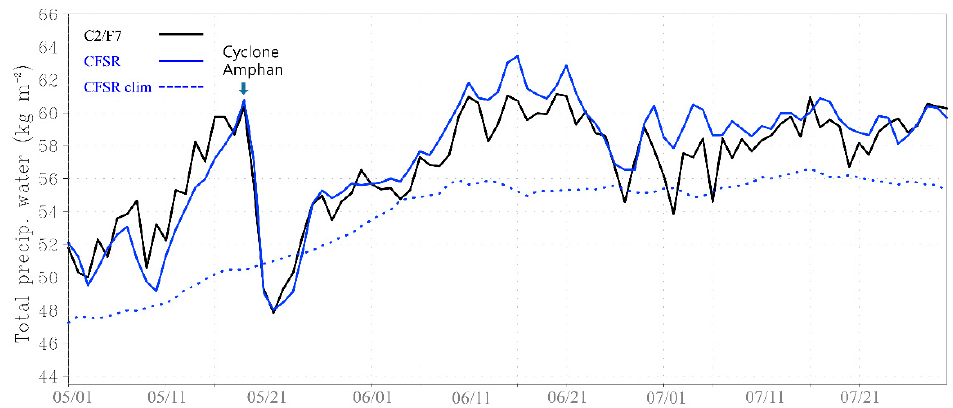
Figure 7. The daily total precipitable water in the Bay of Bengal during 1 May–30 July 2020, retrieved with the COSMIC-2/FORMOSAT-7 RO observations (black curve) and CFSR data (blue solid curve). The blue dotted curve denotes the 41-year (1979–2019) climatological average with the CFSR data.